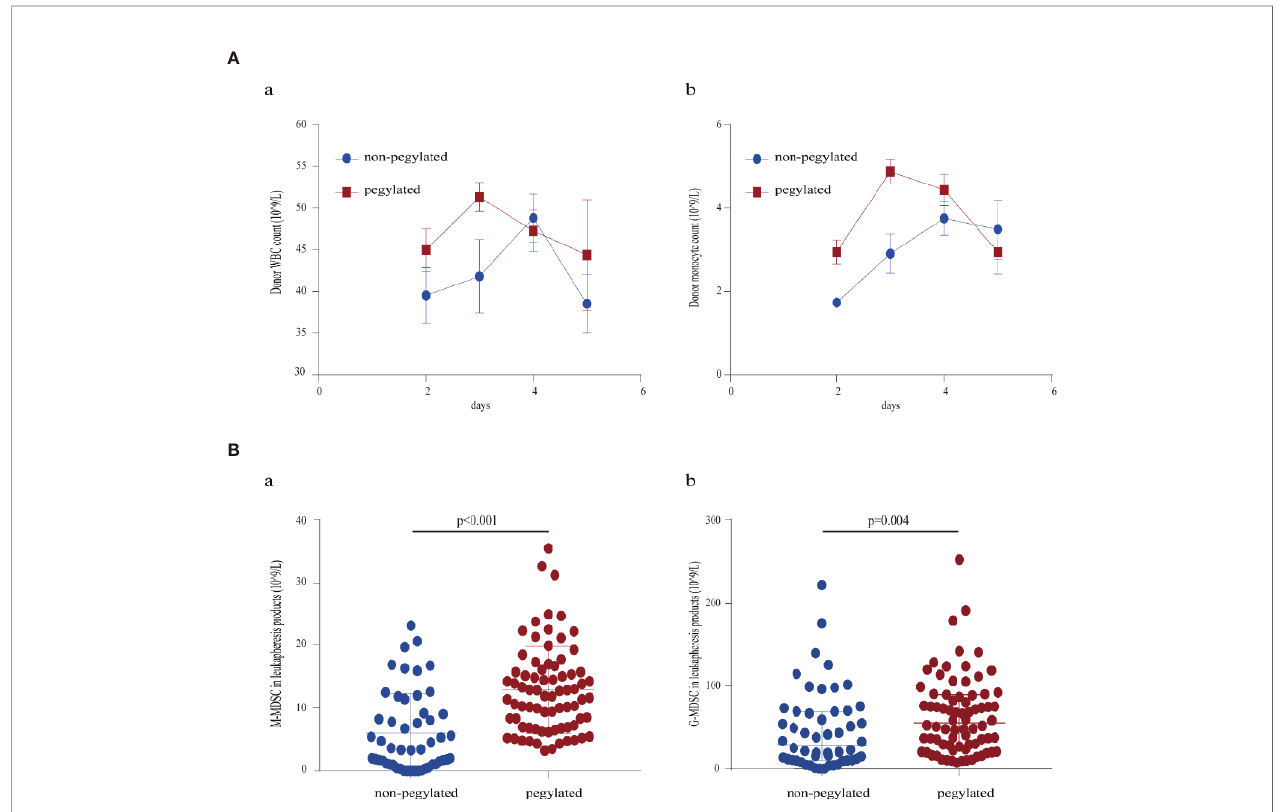
FIGURE 1 | (A) Course of donor peripheral blood leukocytes: (a) white blood cell counts (b) monocyte counts; (B) MDSC content of fi rst leukapheresis products: (a) M-MDSC in leukapheresis products (b) G-MDSC in leukapheresis products.